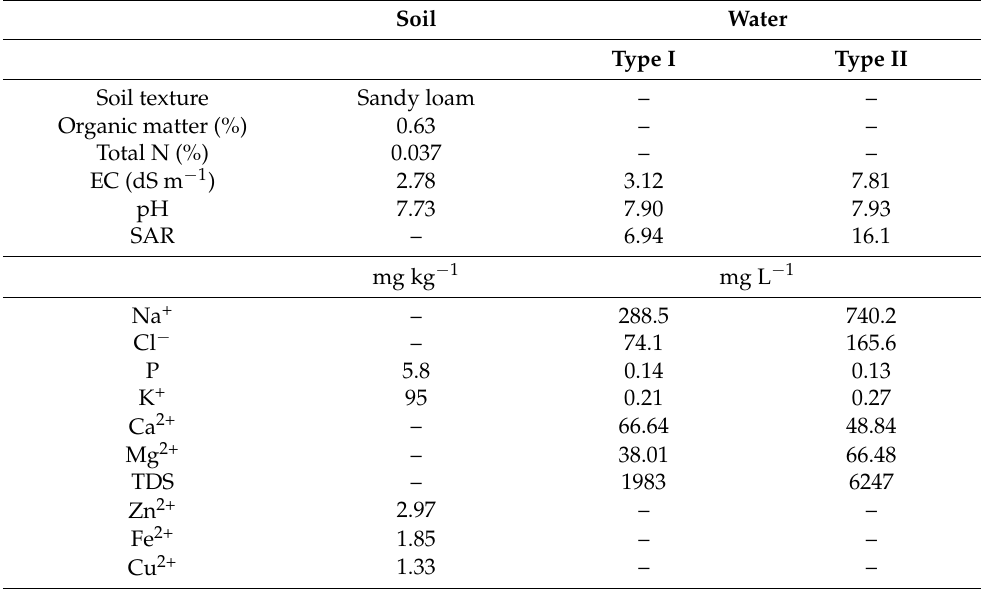
Table 4. Physical and chemical properties soil and water available at Hada